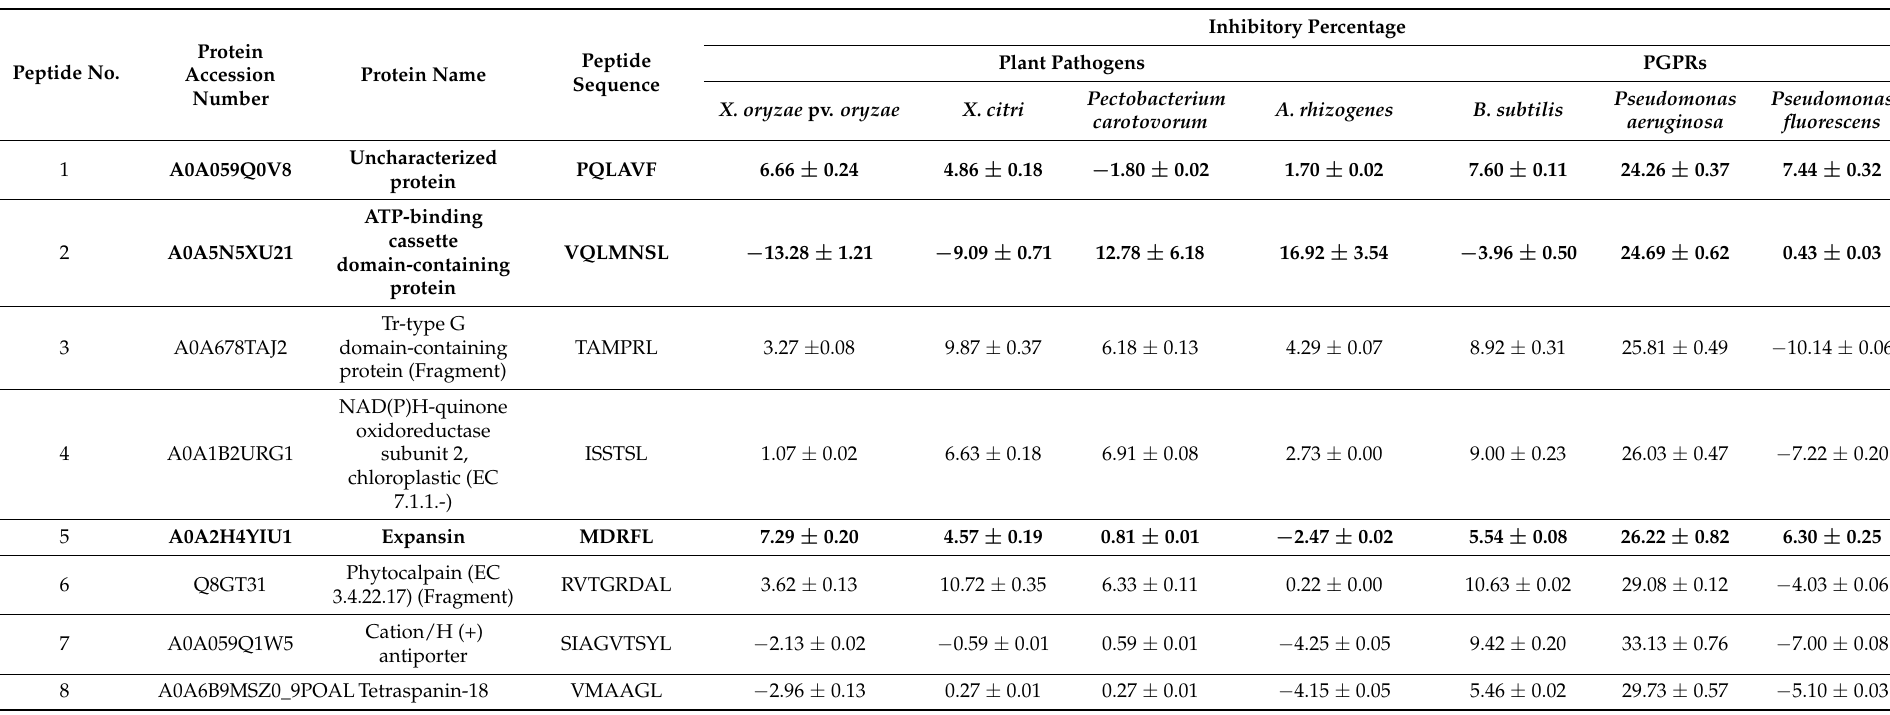
Table 5. Inhibitory percentages of small synthetic peptides derived from purified protein hydrolysates of bagasse ( Saccharum sp .; AW6).